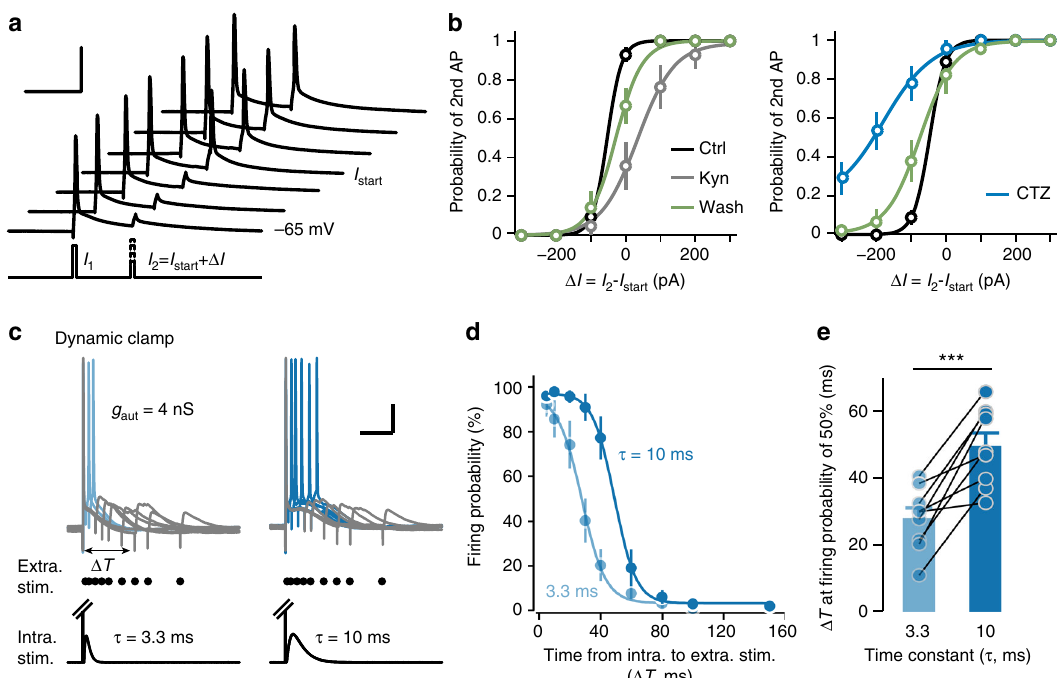
Fig. 7 PC autapses promote coincidence detection. a Examining cell responsiveness to a second current pulse ( I 2 ) shortly after the fi rst stimulation ( I 1 ) that evoked APs reliably. The inter-stimulus interval is 20 ms. I start is the current of the second pulse that evokes AP at a probability of ~0.9 in control condition. Changing I 2 from I start with increment of Δ I to examine the current threshold (i.e., AP probability at 0.5). Scale bars: 20 ms/50 mV. b Probability of the 2nd AP versus Δ I in different conditions (Kyn 1.5 mM and CTZ 100 μ M). Data are presented as mean ± SEM. c Examine coincidence detection with AMPA-only ( τ aut = 3.3 ms, left) or NMDA-containing autapses ( τ aut = 10 ms, right) in short-axon PCs using dynamic clamp. The fi rst AP was evoked by a brief current pulse (1 ms) and followed by g aut injection. Extracellular stimuli were delivered to the neighboring tissue after an interval of Δ T . Scale bars: 50 ms/20 mV. d Plot of the fi ring probability of 2nd AP evoked by extracellular stimulation as a function of the Δ T . e Group data showing the average Δ T at a fi ring probability of 50%. Data are represented as mean ± SEM. *** P < 0.001, paired Student ’ s t